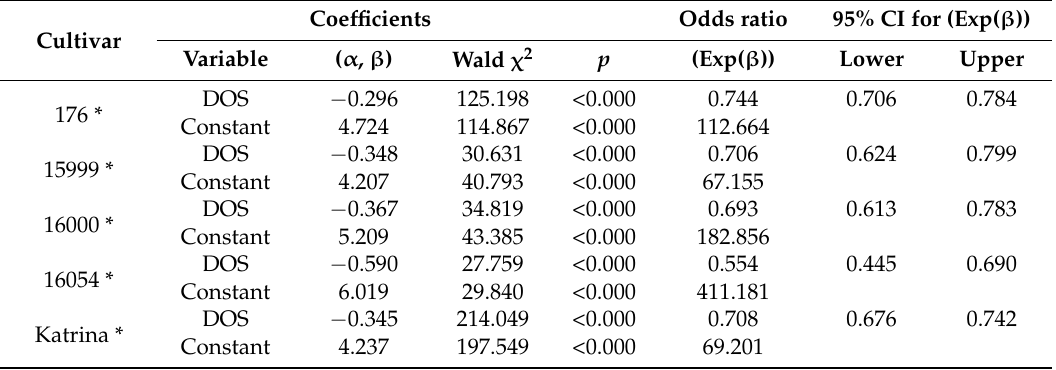
Table 3. Estimation of independent simple logistic regression parameters for each mini cucumber cultivar based on the days of storage (DOS), which is a factor influencing the probability of marketability.